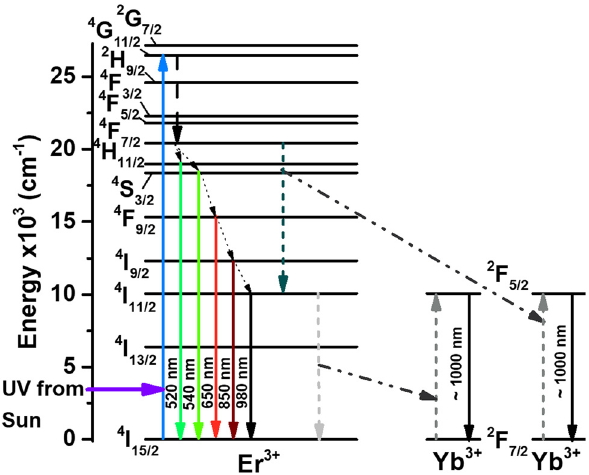
Figure 2: Energy level diagram of the couple of ions Er 3 + – Yb 3 +